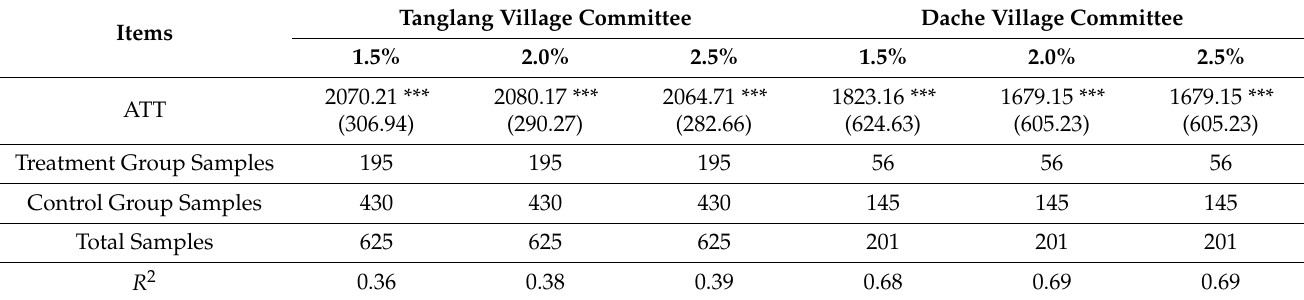
Table 11. Robustness Test